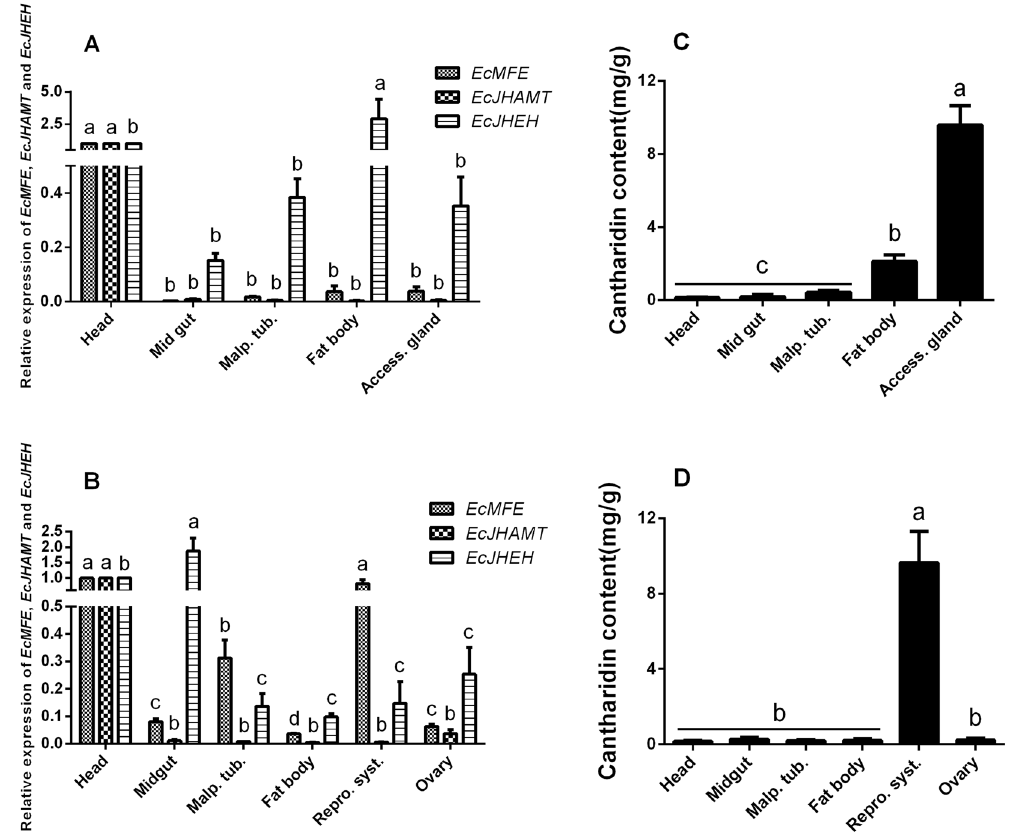
Figure 2. Relative expression profiles of EcMFE , EcJEHE and EcJHAMT mRNA and cantharidin content in different tissues from adult E. chinensis . ( A ) Relative expression profiles in male tissues. ( B ) Relative expression profiles in female tissues. ( C ) cantharidin content in male tissues. ( D ) cantharidin content in female tissues. Different letters on error bars indicate significant differences in each group by one-way ANOVA analysis (P <